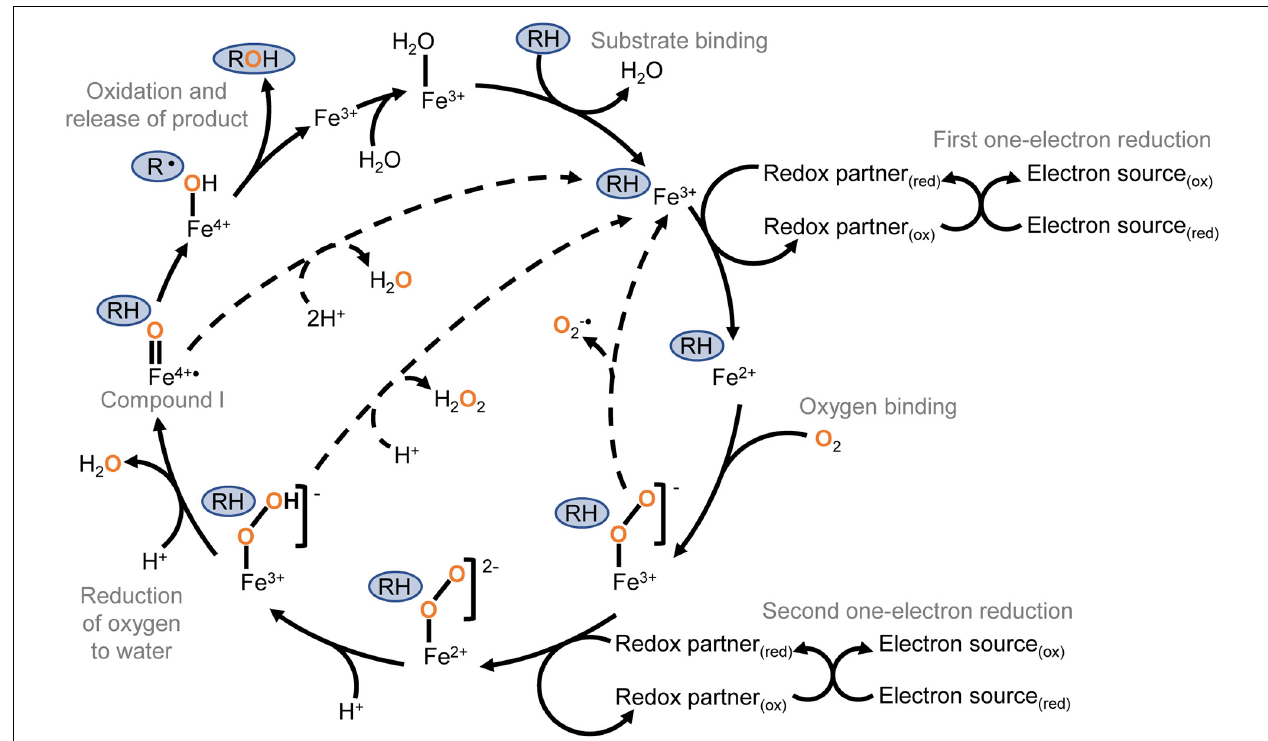
FIGURE 1 | The conventional cytochrome P450 catalytic cycle. Key steps are labelled with grey text. The substrate is marked in a blue oval, and oxygen atoms originating from molecular oxygen are shown in orange. The conventional cycle is shown with solid arrows, and uncoupling routes with dashed arrows. The cycle begins with the enzyme in the “resting state” where a water ligand occupies the active site and the haem iron is in the ferric state. Substrate binding displaces the water molecule and is followed by a one-electron reduction of the haem iron from Fe 3 + to Fe 2 + , creating the opportunity for molecular oxygen to bind the ferrous haem. A second one-electron reduction creates a ferric-peroxo intermediate that is quickly protonated to a ferric-hydroperoxo species. A second protonation results in the release of water and formation of the highly reactive ferryl-oxo porphyrin radical known as “compound I.” Compound I abstracts a hydrogen atom from the substrate, briefly forming a ferryl hydroxide that recombines with the highly reactive substrate radical that resulted from the proton abstraction. The net result of this reaction cascade is monooxygenation of the substrate to form the product and return the haem iron to the ferric state. The P450 catalytic cycle can uncouple (dashed arrows) after either of the one-electron reduction steps, resulting in the release of reduced oxygen as superoxide or hydrogen peroxide. The ferryl hydroxide can also be protonated to cause uncoupling and the release of water without metabolism of the substrate.